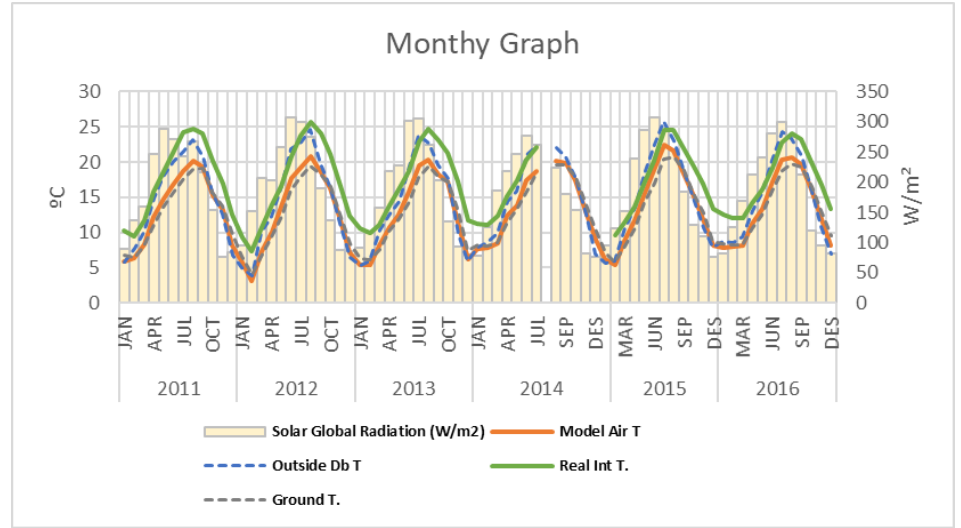
Figure 20. Comparison of real interior temperature and model temperature from the EnergyPlus